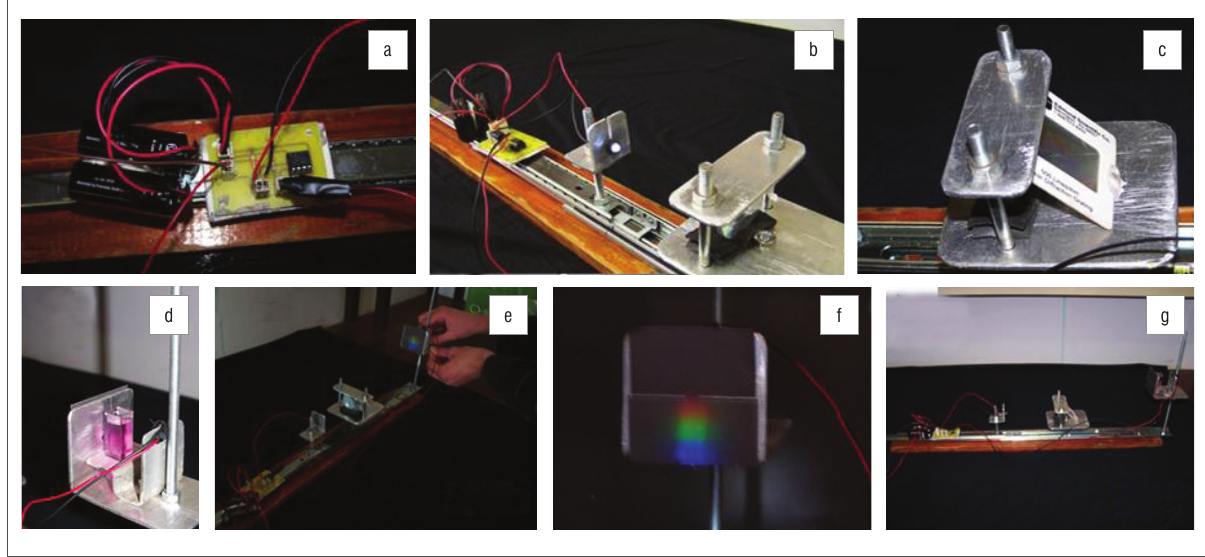
Figure 4: Components of the SpecUP spectrophotometer: (a) printed circuit board with batteries, (b) LED light source, (c) lens and diffraction grating, (d) slit and sample holder with sample, (e) adjustment of the slit position and (f) light separation at the slit. (g) Side view of the Mode 1